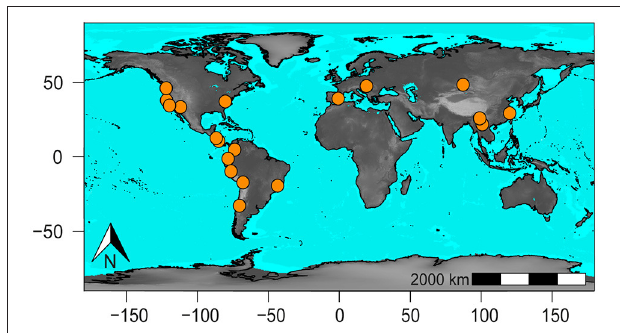
FIGURE 1 | Geographic distribution of the studies (i.e., study sites for field studies, author’s affiliation for reviews) contained in the Research Topic. The background map is the elevation gradient derived from ASTER GDEM (https://